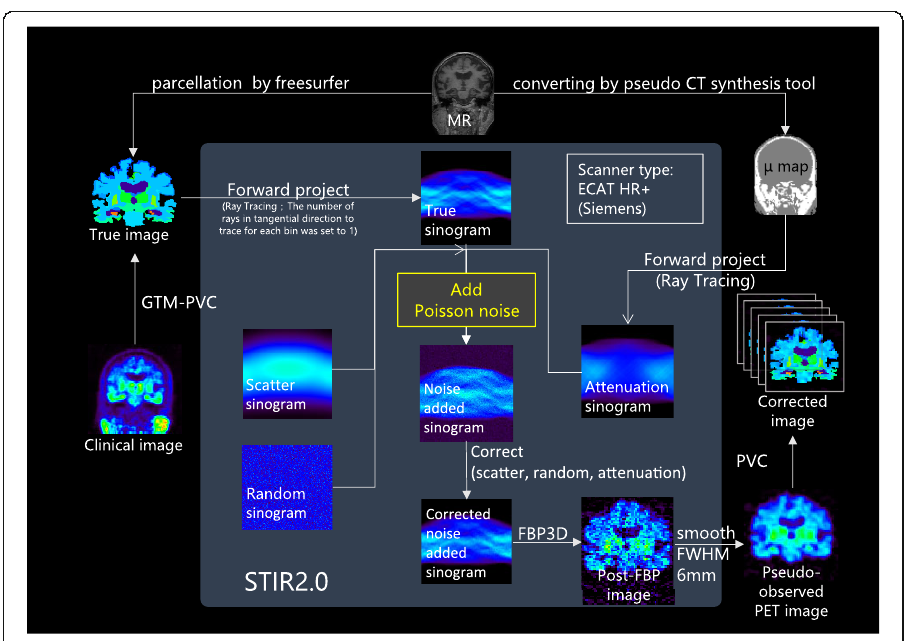
Fig. 1 Schematic flow of the data processing